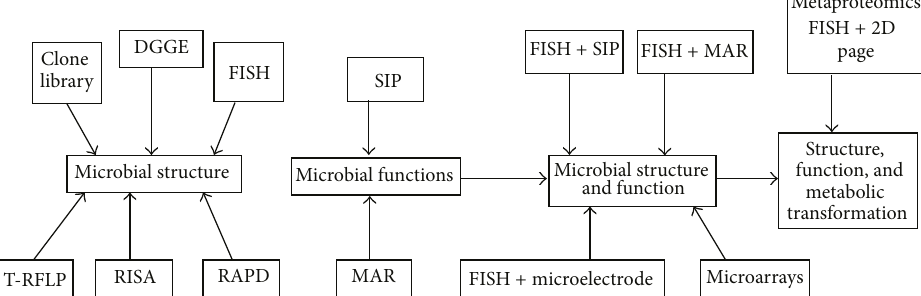
Figure 5: Conceptualization of the role of currently available molecular biology and postgenomic techniques for analysis of microbial community structure, function, and metabolic transformation